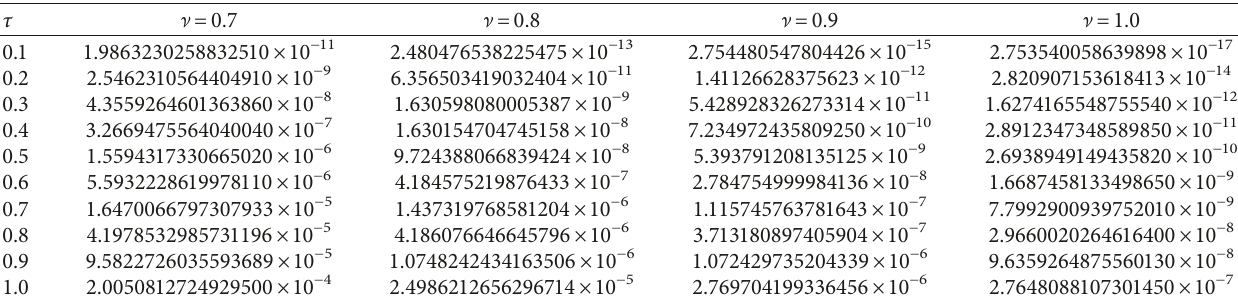
Table 5: The recurrence error of the 5th approximate solution of the real part in Example 1.